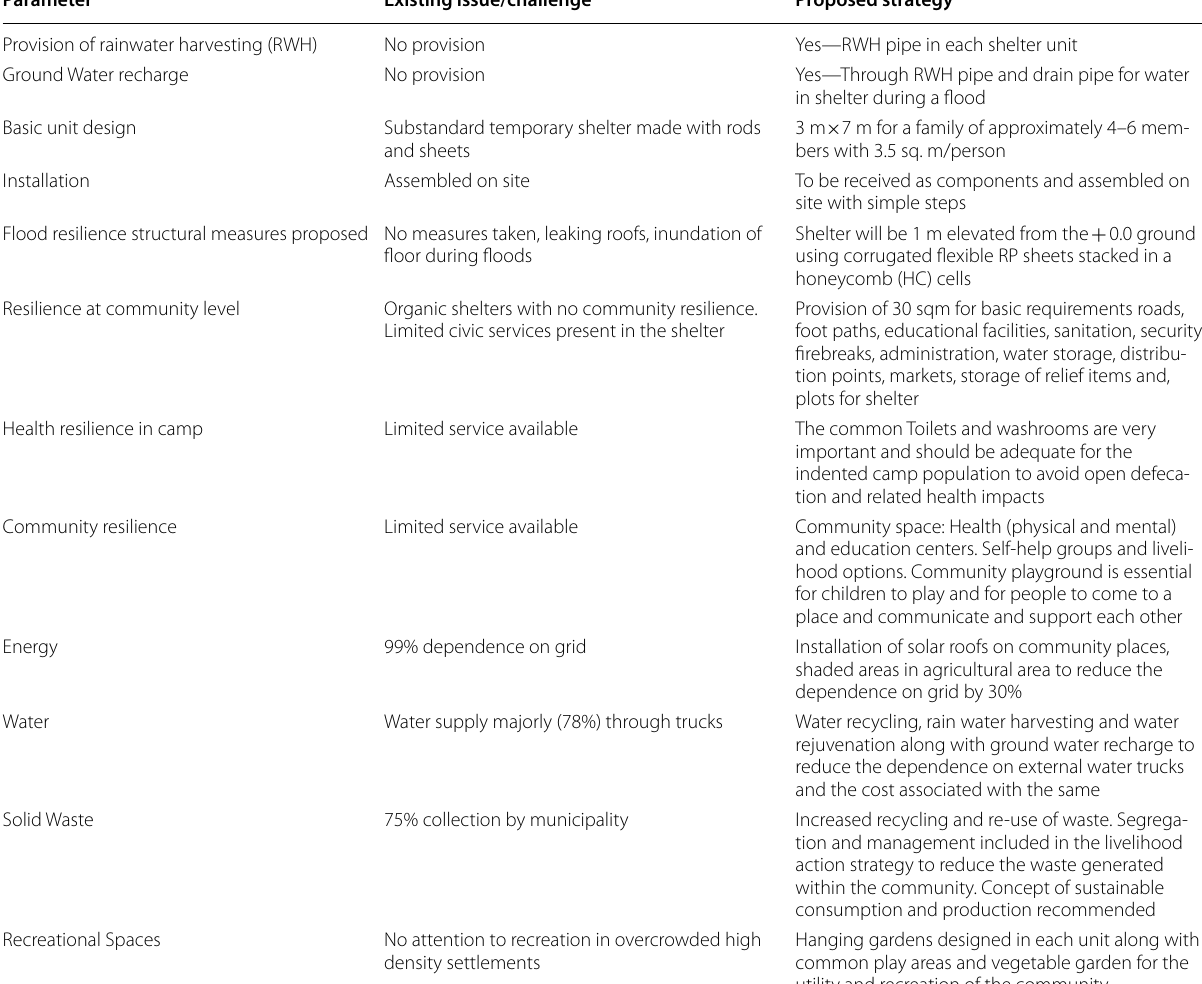
Table 1 Summary of Design intervention in camp for resilience (from Al Azzawi et al. 2020 and after UNHCR 2000)